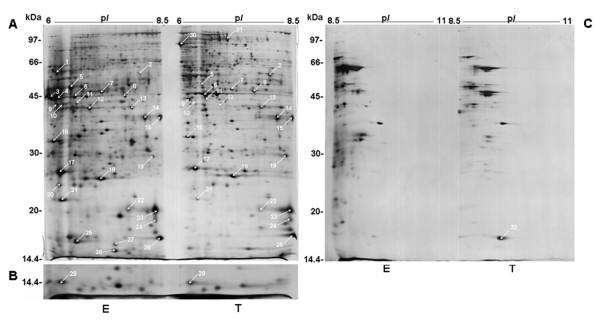
2-DE comparison between T. cruzi motile life forms using alkaline "two-in-one gel". IPG strips with epimastigote (E) and trypomastigote (T) samples were applied side-by-side on 12% T SDS-PAGE (see Material and Methods). A: "two-in-one gel" of 6–8.5 pH range. Spot 29 is shown in an inset (B) of a separate experiment. C: "two-in-one gel" of 8.5–11 pH range. Gels were silver stained.